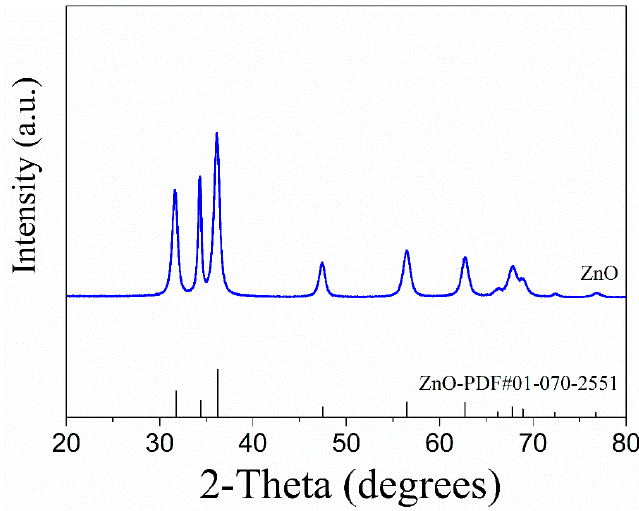
Figure 7. XRD pa tt ern of ZnO-NPs and ZnO standard PDF